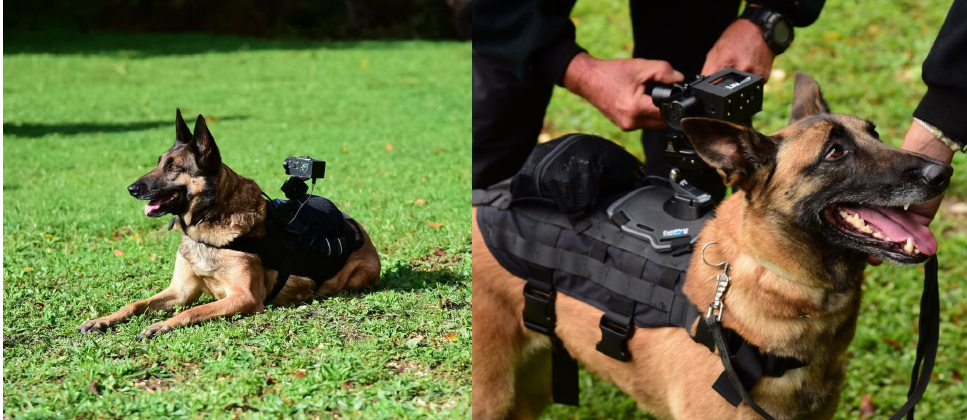
Figure 2. Both modules attached on the vest during the second round of testing.